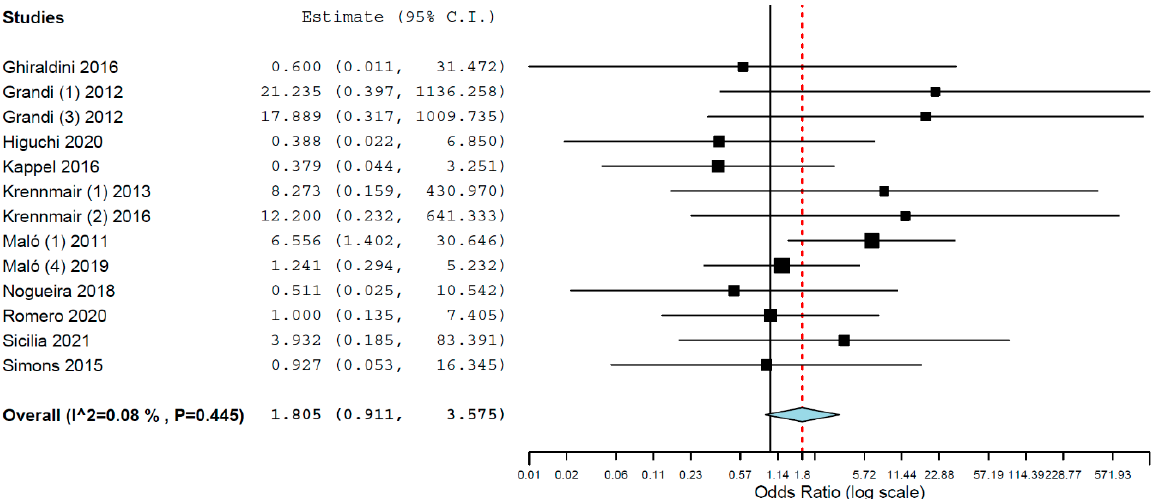
Figure 4. Forest plot for the event ‘implant failure’, studies evaluating implants inserted exclusively in mandibles.